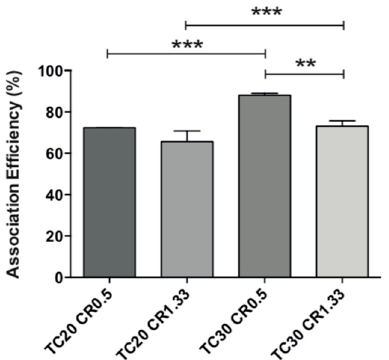
Figure 4. Association efficiency of four different EE/alginate 30% w / w Lys pNPs with various total charges (TC) and charge ratios (CR). Statistical significant of the differences were assessed by an analysis of variance ANOVA, followed by the Tukey test. ** ( p < 0.001), *** ( p < 0.0001) and **** ( p < 0.00001).